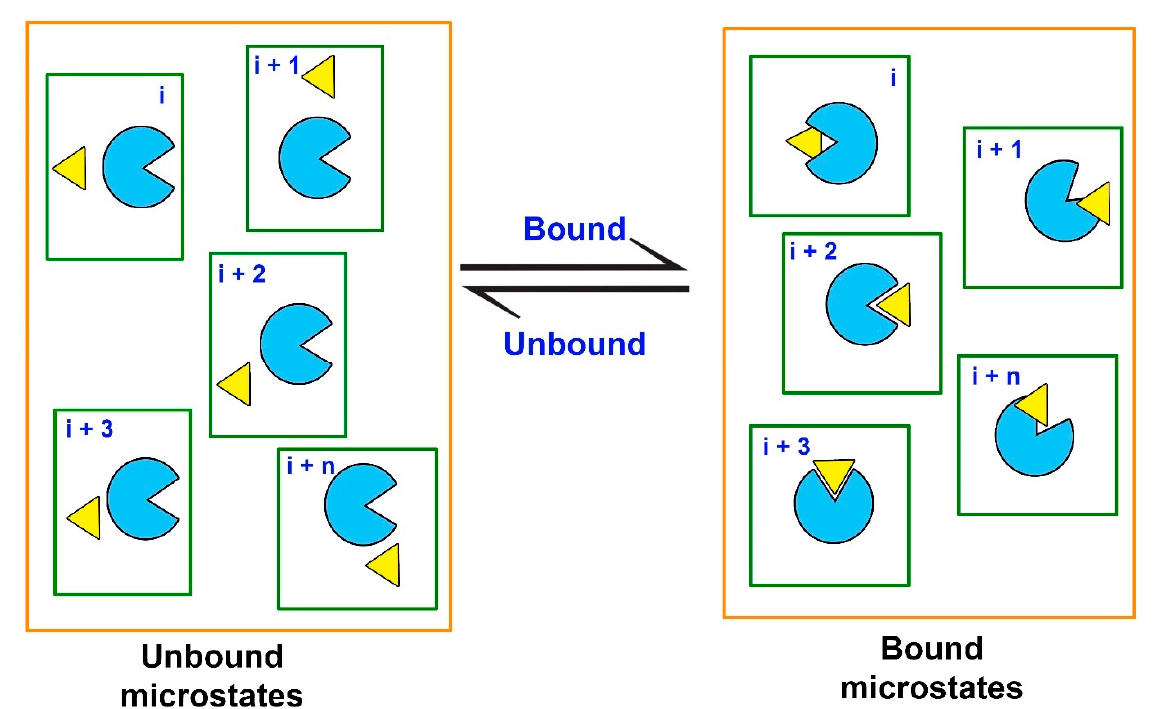
Figure 6. Equilibrium states (macrostates, delineated by orange lines) are represented by ensembles of discrete microstates for a protein (light blue) and a ligand (yellow) in a solvated system (delineated by green lines).